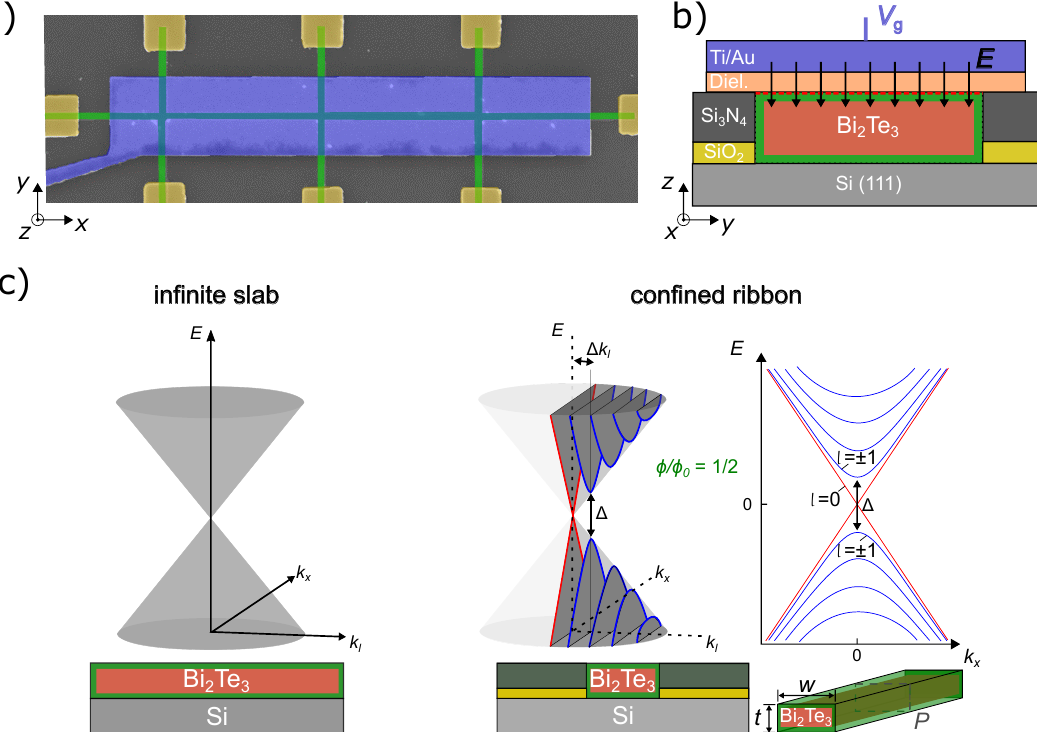
Figure 1: Dispersion relation in thin films and in confined nanoribbons of Bi a) A false-colored scanning-electron micrograph of a gated, 200 nm-wide Hall bar is shown. The contact electrodes on the TI (green) are highlighted in ochre and the top gate electrode is highlighted in blue. b) The device geometry including the SAG mask (yellow and dark grey), the Bi surface and bulk regions, respectively), the gate dielectric (rose) and the top gate electrode (blue) is schematically shown. c) The dispersion E ( k states on the surfaces of an infinite slab of Bi row nanoribbon geometries the subband level spacing ∆ k decreasing nanoribbon perimeter P = 2 · ( W + t ) , where W and t are the width and the thickness of the nanoribbon,